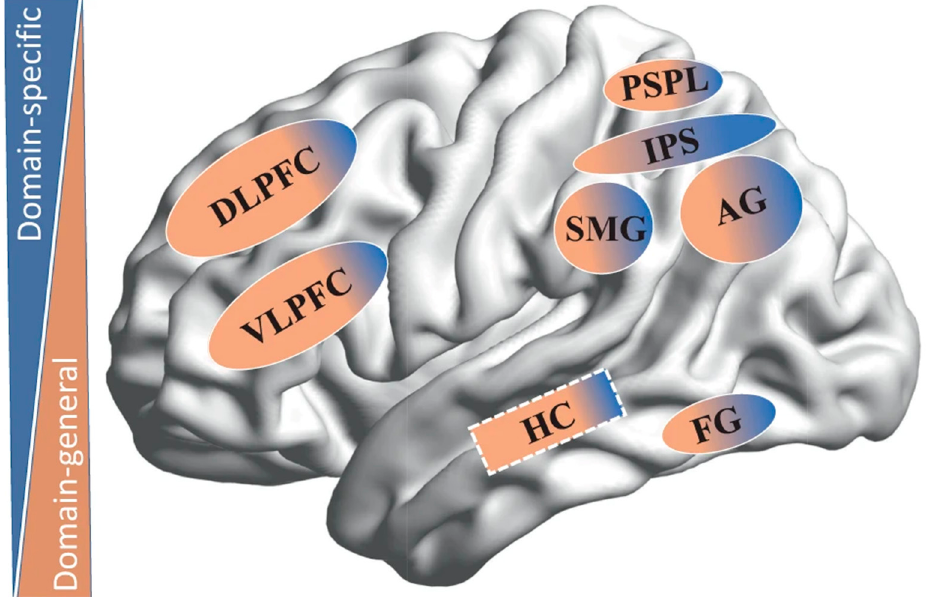
Figure 1. Neurobiological bases of numerical cognition. The neurocognitive bases are described as interactions of multiple brain networks—especially the fronto-parietal network—that supports domain-specific mechanisms (blue color coding) and domain-general processes (orange color coding). Legend: DLPFC = dorsolateral prefrontal cortex, VLPFC = ventrolateral prefrontal cortex, PSPL = posterior superior parietal lobe, IPS = intraparietal sulcus, SMG = supramarginal gyrus, AG = angular gyrus, FG = fusiform gyrus, HC = hippocampus. Reproduced from reference [18], 10.1038/s41539-021-00099-3, under the terms of the CC BY 4.0 license, http://creativecommons.org/licenses/by/4.0/ (accessed on 29 March 2022).